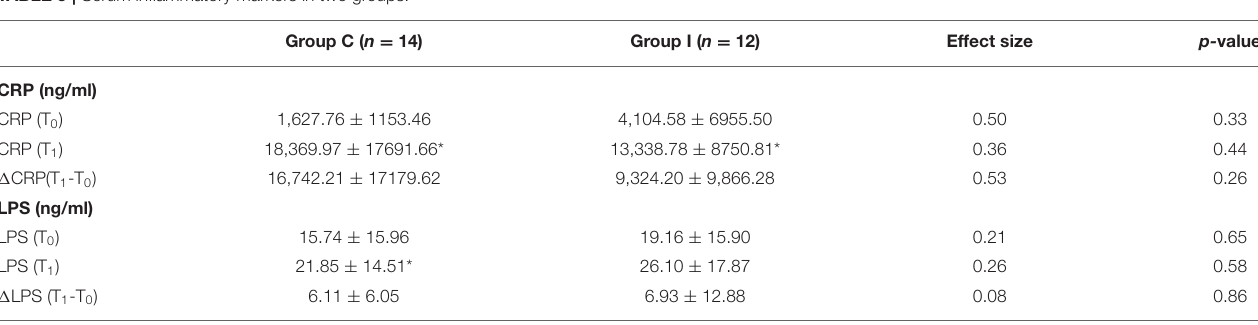
TABLE 5 | Serum inflammatory markers in two